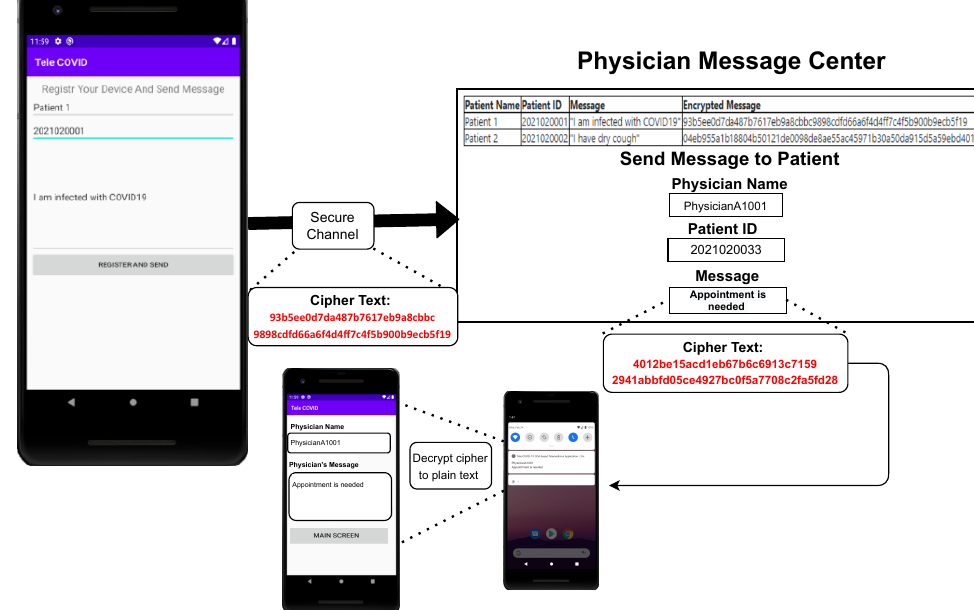
Figure 6. Tele-COVID messaging process from patient to physician.